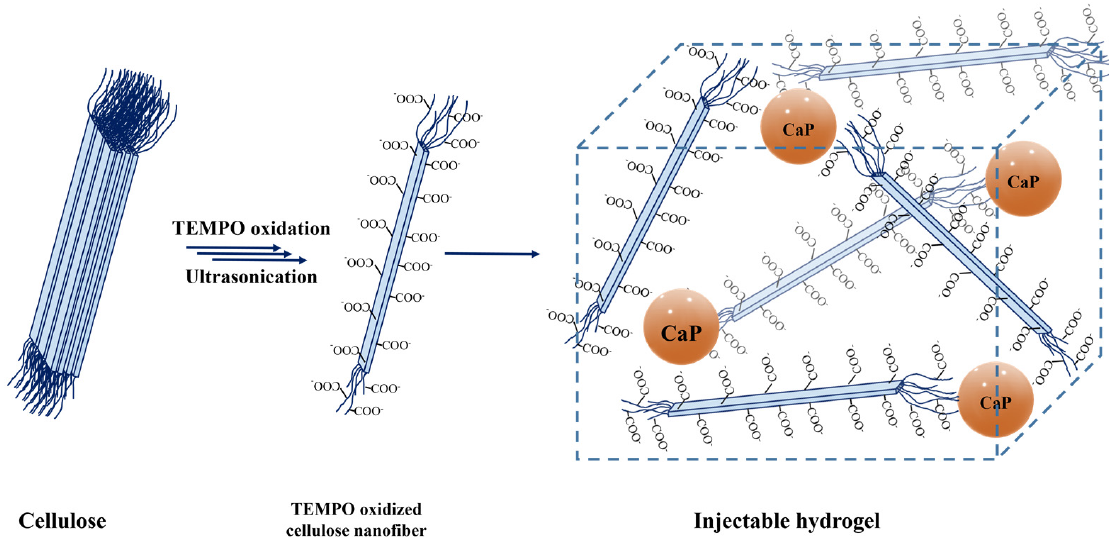
Figure 1. Schematic representation of the production of TOCNFs-CaP/CaPGO hydrogels. The pristine cellulose was converted to TEMPO oxidized cellulose nanofibers by means of TEMPO/KBr/NaClO oxidative system followed by an ultrasonic assisted dispersion. Inorganic particles were added to the achieved dispersion in order to induce the sol-gel transition.